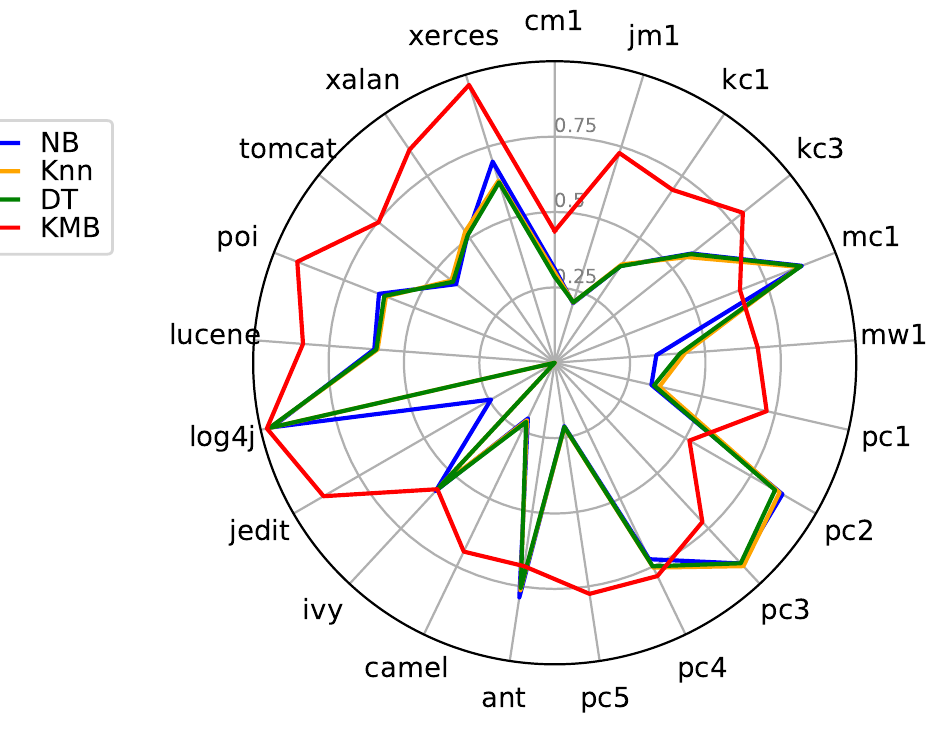
Figure 6. Recall for the basic classifiers and KMB.